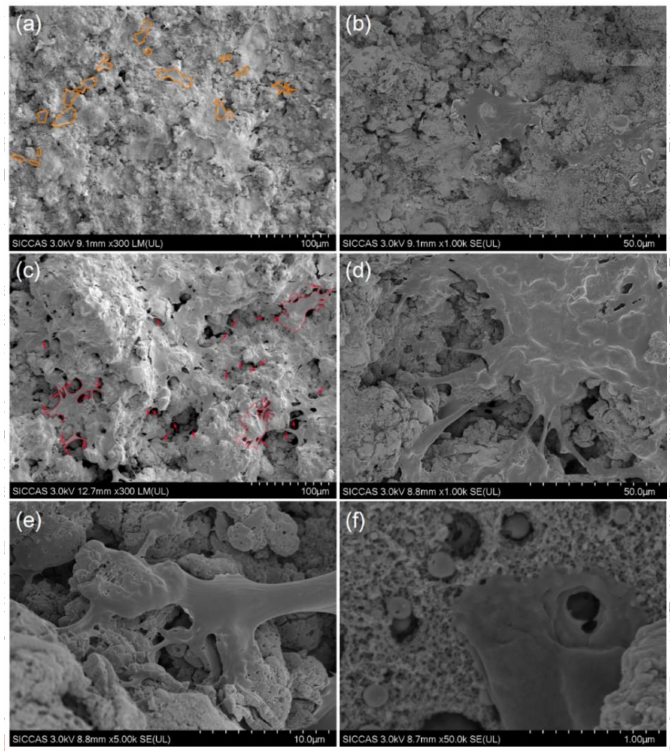
Figure 9. SEM images of morphology of cells after 4 days on ( a , b ) MNT coating and ( c – f ) MNT coating under different magnifications. From ( b ), cell on MT coating presents spindle morphology with less stretched morphology. From ( d ), it shows fully spread cell with well-stretched morphology and a relatively large size on MNT coating. From ( e ), it presents a good interaction between the nanotube surface and the filopodia of hBMSC; From ( f ), a filopodia presents a good interaction with the MNT surface. (The orange outlines indicate the approximate morphology of cells on the surface of MT coating. The red arrows mark the filopodia of hBMSCs on MNT coating.).